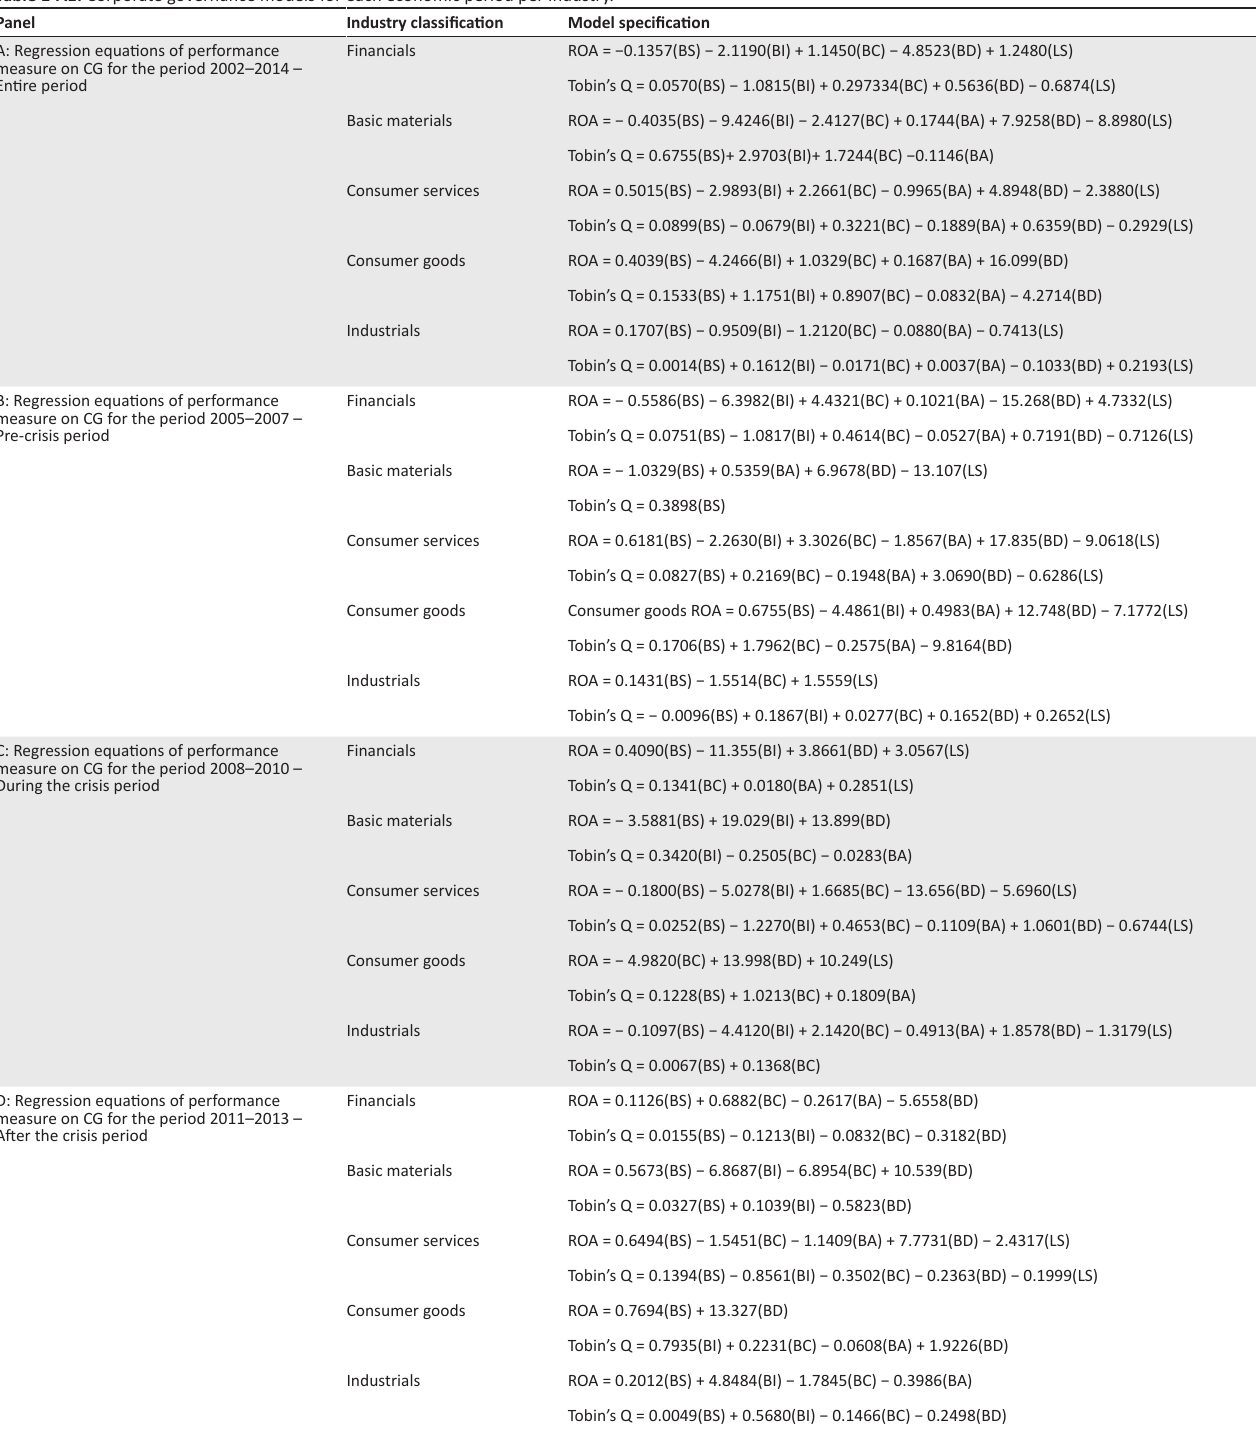
Table 1-A1: Corporate governance models for each economic period per